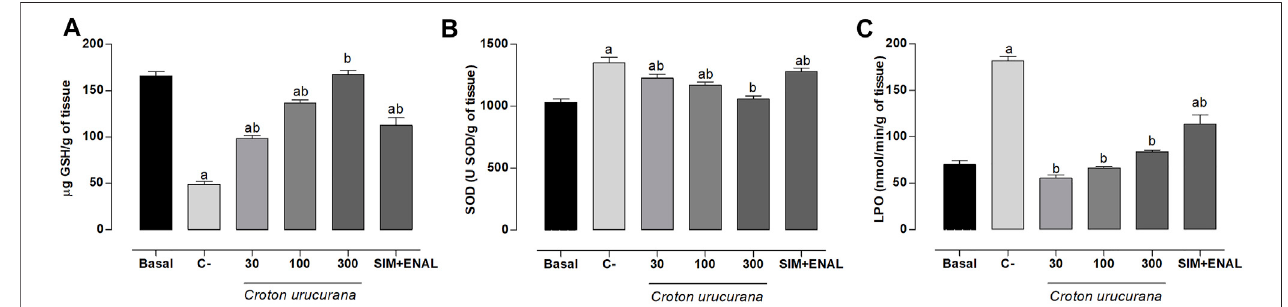
FIGURE 3 | Antioxidant effects of Croton urucurana . (A – C) Hepatic levels of reduced glutathione (A) , lipoperoxidation (B) , and superoxide dismutase (C) in normotensive,non-dyslipidemic,andnon-smokerrats(basalgroup)andhypertensive,dyslipidemic,andsmokerspontaneouslyhypertensiveratsthatweretreatedwith